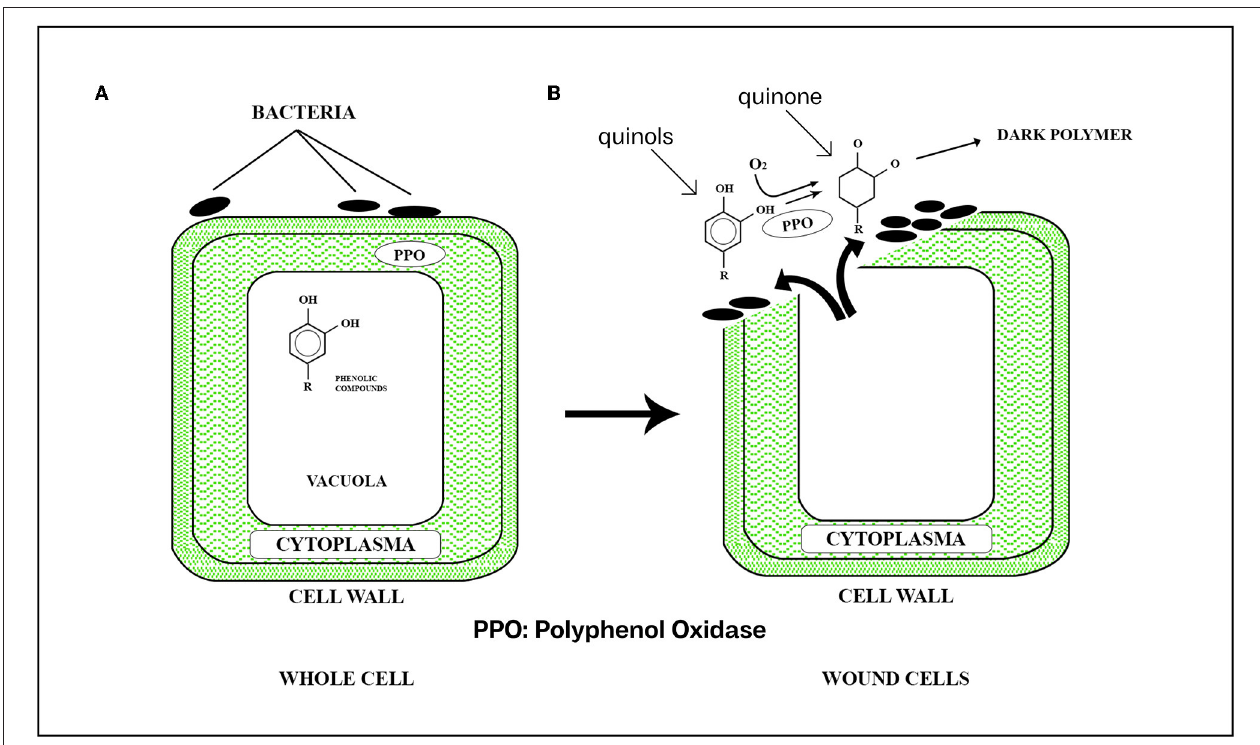
FIGURE 1 | Whole cells (A) and cells that are injured or cut (B)